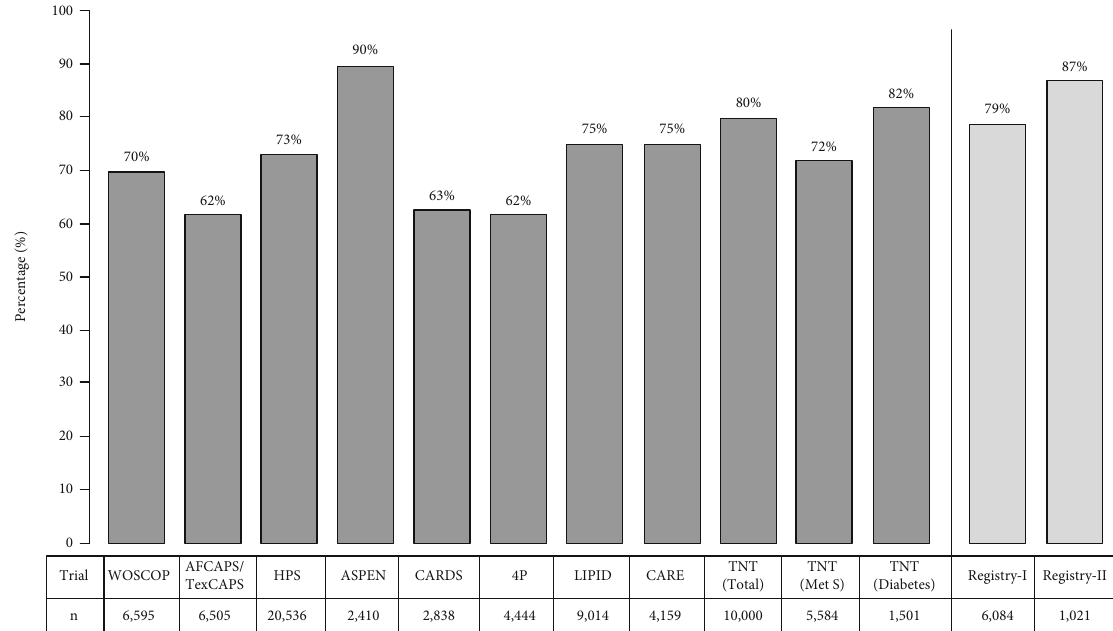
Figure 6: A hypothetical comparison of high residual risk reported by major statin trials versus the high sub-optimal vascular reactivity index (VRI) in digital thermal monitoring (DTM) registries. Created based on “ Residual risk: Is LDL target enough?